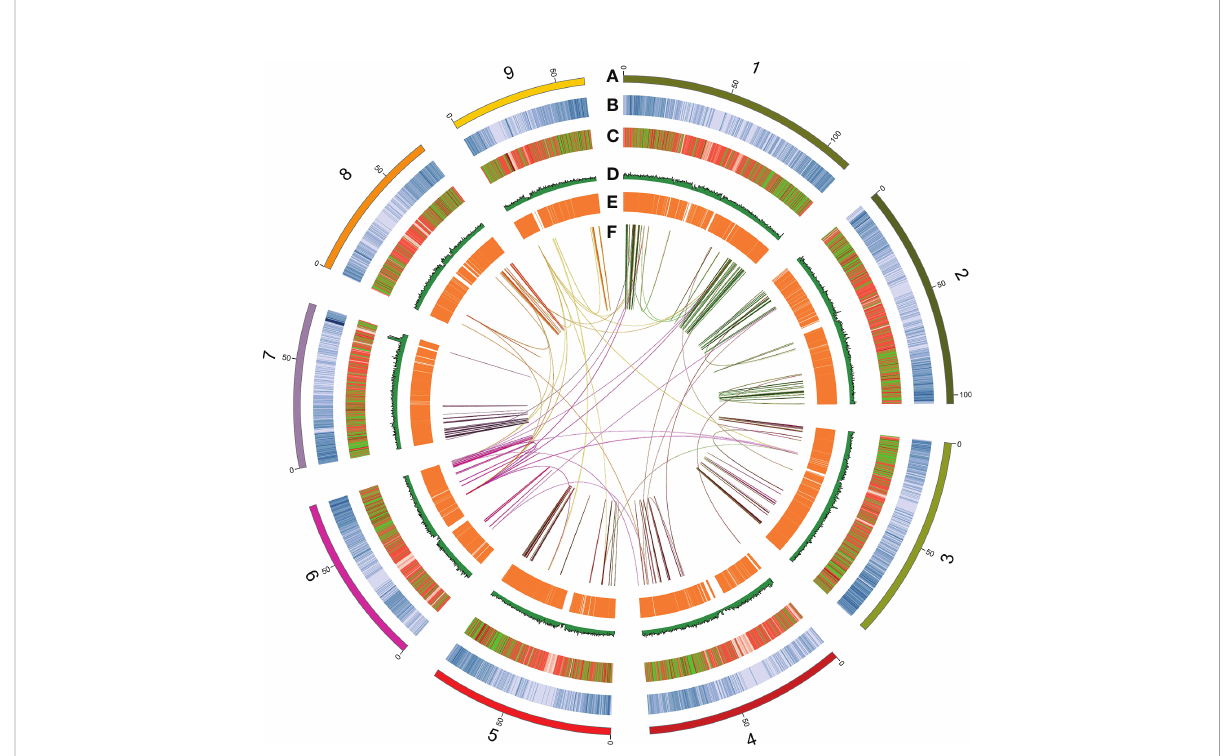
FIGURE 1 Circos plot showing the distribution of genomic features along the IMA1 genome. The rings from outermost to innermost indicate (A) nine pseudo-chromosomes of Beta vulgaris IMA1genome; (B) gene density distributed inside 200-kb sliding windows; (C) transposable element abundance; (D) distribution of GC content; (E) expression values of leaf-expressed genes; and (F) schematic presentation of major inter- chromosomal relations in the B vulgaris IMA1 genome. Each line represents a syntenic block; block size = 3 kb. Chromosomes in the outer ring are ordered by chromosomes length as follow:1, chr5; 2, chr4; 3, chr3; 4, chr7; 5, chr6; 6,chr9; 7, chr1; 8, chr8; 9,